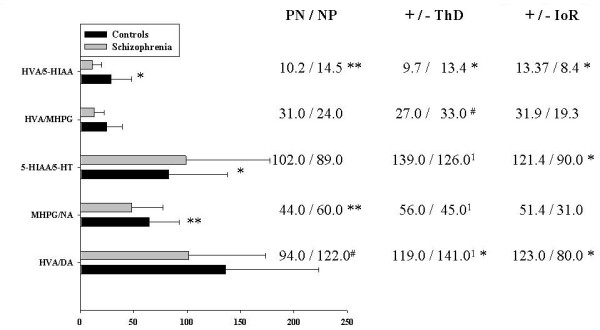
Metabolite/monoamine turnover ratios for the whole subject group (bar diagram, left) and for patient sub-groups (tabular, right: PN, paranoid; NP, nonparanoid; ThD, thought disorder [+/-, high/low]; IoR, ideas of reference [+/-, high/low]). #P < 0.08, *P < 0.05, ** P < 0.01. 1 = levels of metabolite. Units: inter-amine ratios ×10; 5-HT TR ×103; DA and NA TR ×10.